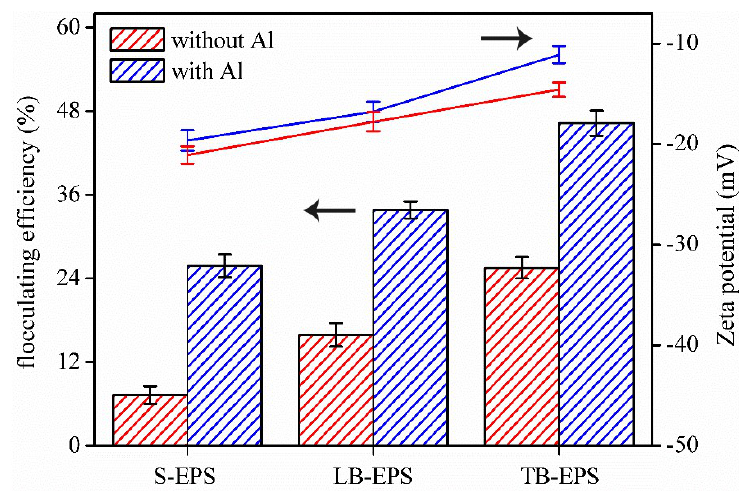
Figure 5. Zeta potential and flocculation efficiency of each EPS fraction.